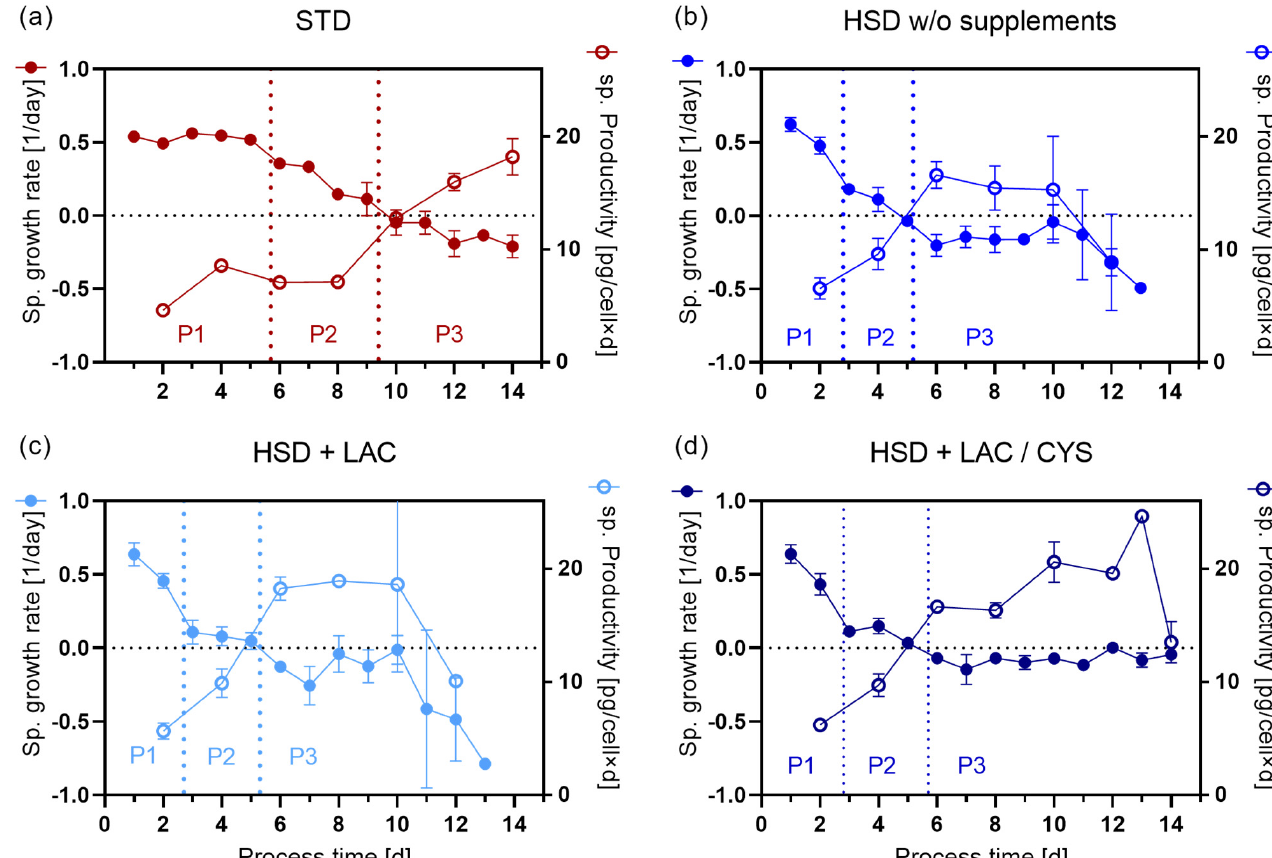
Figure 5. Illustration of identified phases with the data of specific growth rate and specific productiv- ity against the process time for the processes: ( a ) standard (2), ( b ) HSD10M without supplementation (5), ( c ) HSD10M with LAC supplementation (3) and ( d ) HSD10M with LAC/CYS (2) supplementa- tion. The number in the brackets behind the process types shows the number of runs which were used for this analysis. STD, standard process with seeding density of 0.7 × 10 6 cells/mL; HSD10M, process with the seeding density 10 × 10 6 cells/mL; +LAC, supplemented with lactate; +LAC/CYS, supplemented with lactate and cysteine.